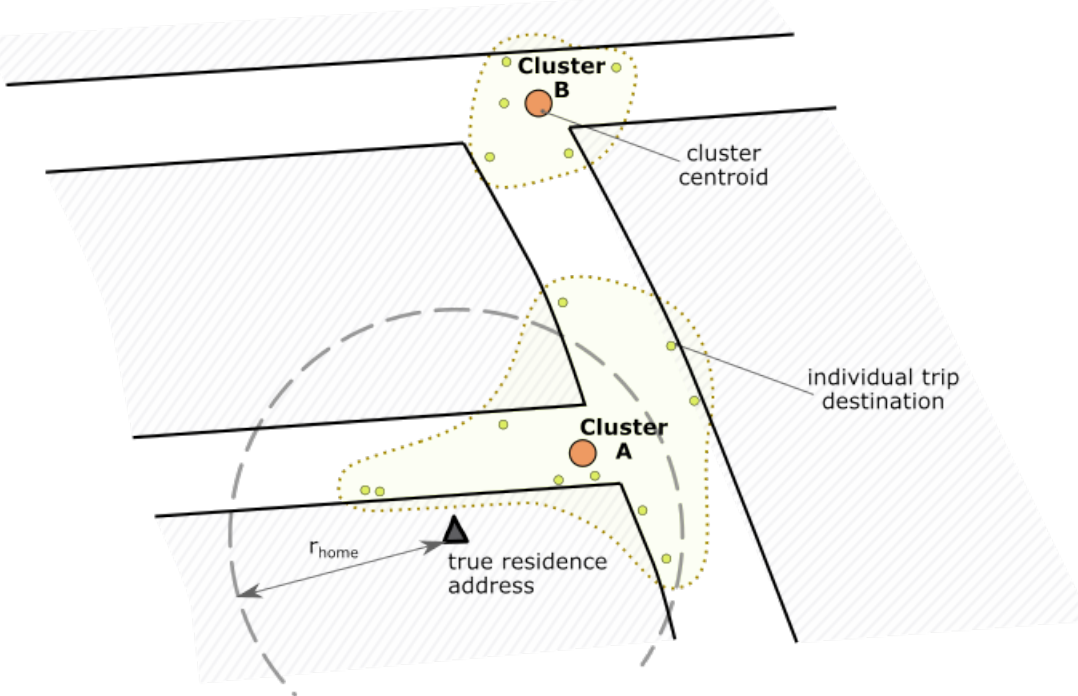
Figure 1. Methodology